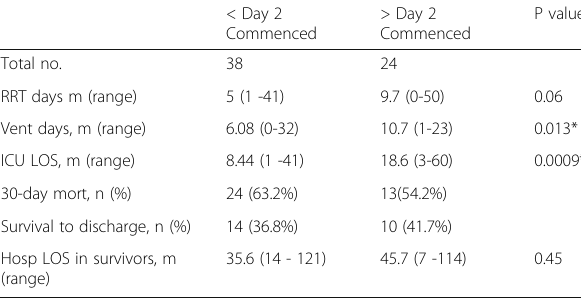
Table 65 (abstract A192). Outcome